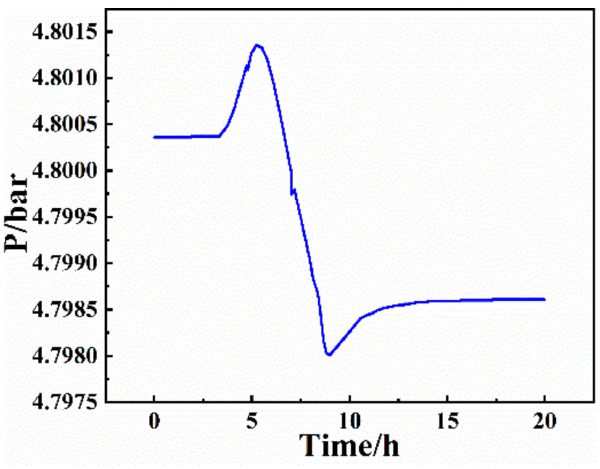
Figure 7. Pressure changes of